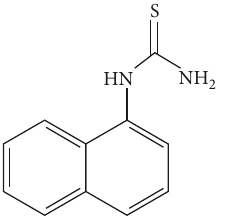
Figure 1: Chemical structure of ANTU ( α